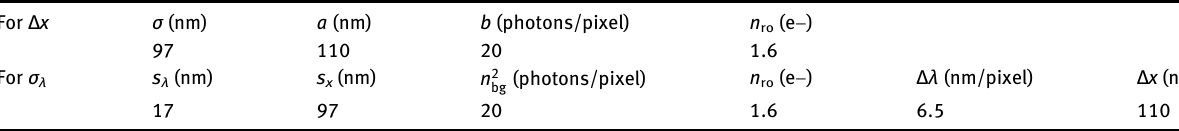
Table  : List of parameters used in analytical solutions. For Δ x